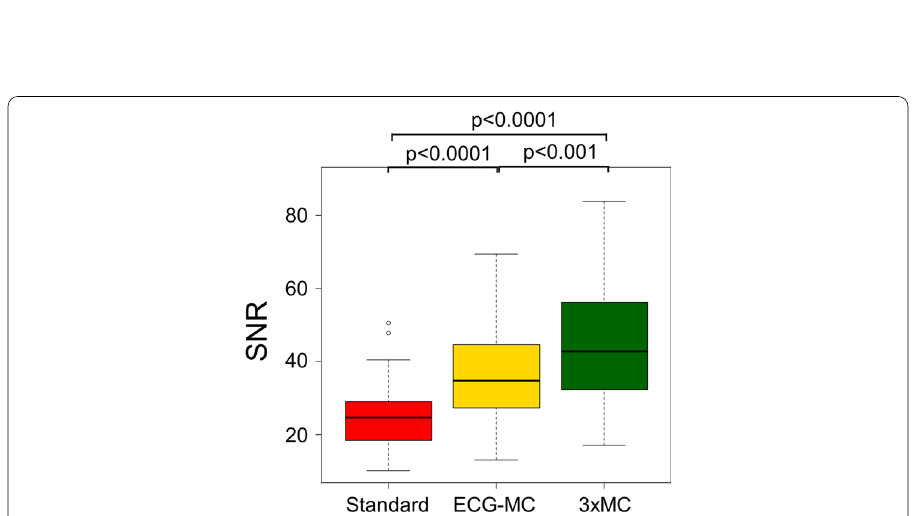
Fig. 5 Signal-to-noise ratio (SNR) measurements obtained for the three reconstructions. End-diastolic (Standard) measurements were reported to have significantly lower SNR when compared to the motion-corrected datasets (ECG-MC and 3 3 MC triple × =